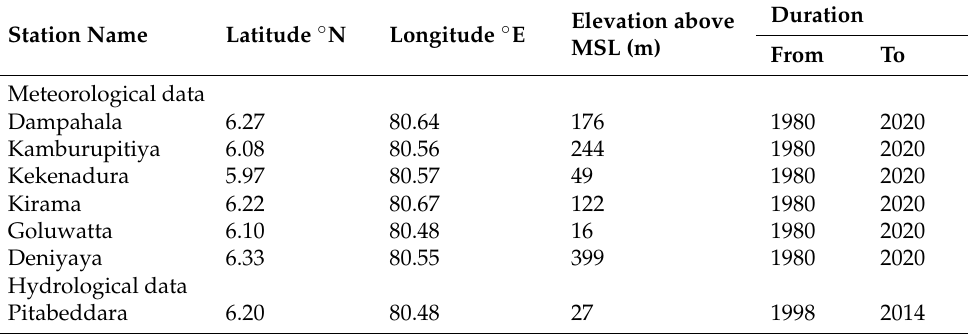
Table 1. Details of the hydro-meteorological stations in the